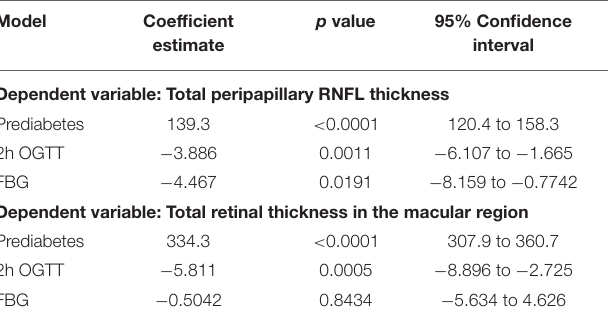
TABLE 4 | Results of multivariable regression models-dependent variable. p Model Coefficient estimate